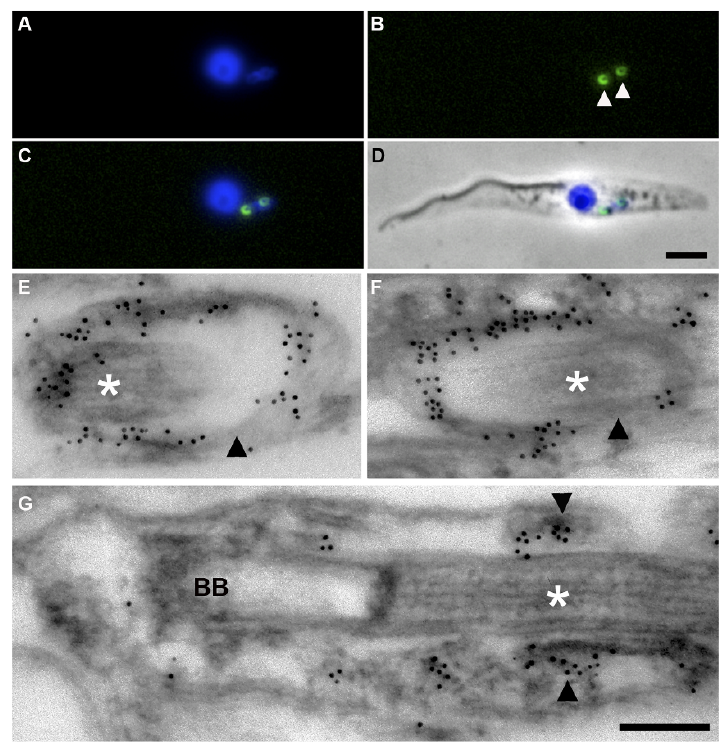
Figure 3. Cellular localization of Tb BILBO1 in procyclic cells: ( A – D ) Micrographs of a PF cytoskeleton labeled for immunofluorescence. The cell has duplicated its FPC and the daughter is located in the posterior rounded end of the cytoskeleton. The cytoskeleton was probed with monoclonal anti- Tb BILBO1 and DAPI. ( A ) DAPI; ( B ) monoclonal anti- Tb BILBO1 (white arrowheads); ( C ) merged DAPI, anti- Tb BILBO1; and ( D ) merged DAPI, anti- Tb BILBO1 and Phase contrast. Scale bar: 5 µ m. ( E – G ) Electron micrographs of immunogold-labeled thin sections through the T. brucei FPC (black arrowheads). The FPC was labeled after detergent extraction using a monoclonal anti- Tb BILBO1 antibody followed by 10 nm gold-conjugated anti-mouse antibodies. Micrographs ( E , F ) are longitudinal sections of the FPC and ( G ) is a longitudinal section of the axoneme (BB, basal body). Asterisks indicate the axoneme traversing the FPC. Scale bar: 250 nm.